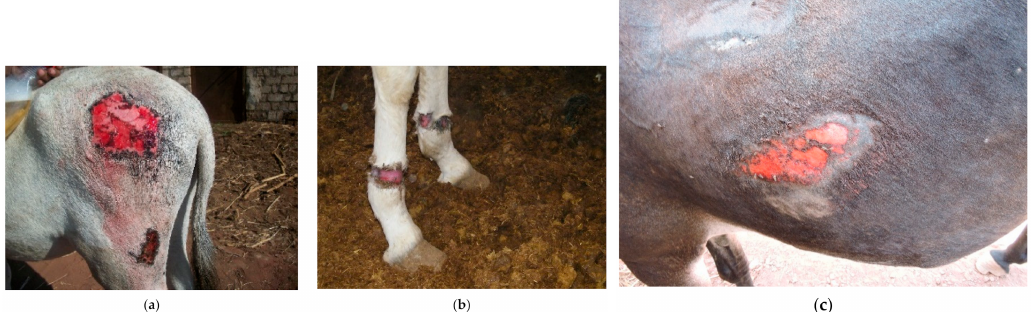
Figure 2. ( a ) A wound from excessive force / beating, ( b ) a limb wound from improper tethering, and ( c ) a shaft wound from the cart.